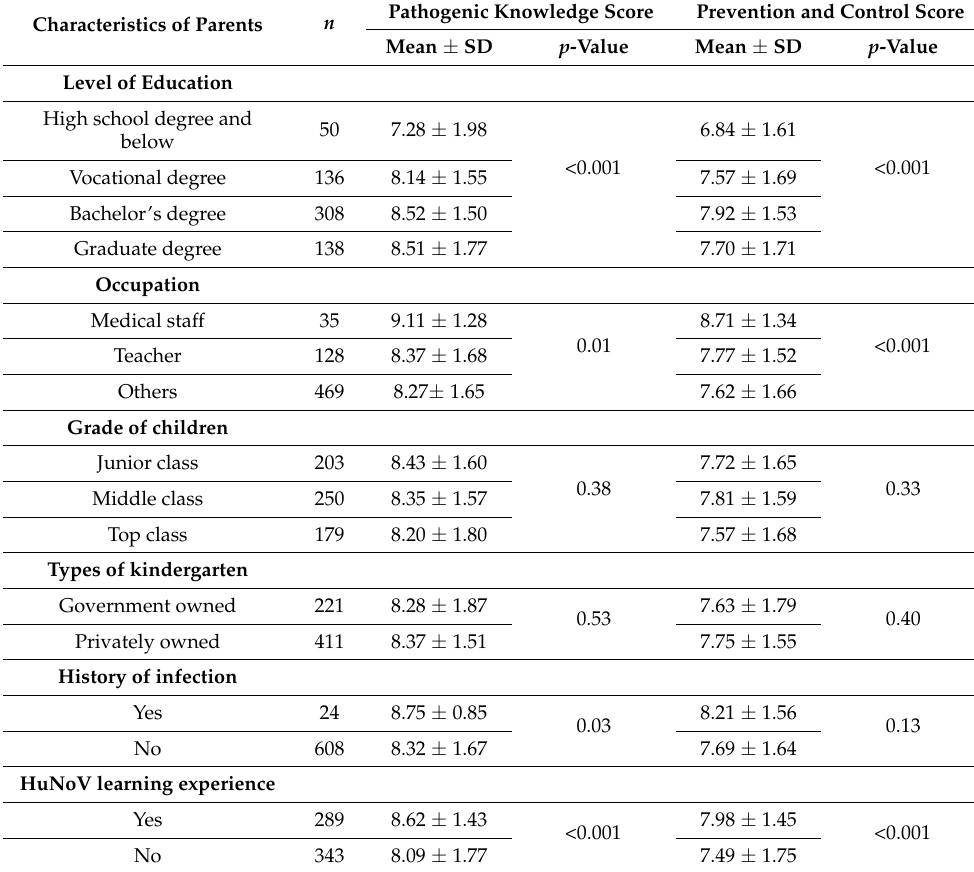
Table 1. Sociodemographic characteristics of parents ( n = 632) and their association with knowledge score. Pathogenic Knowledge Score Prevention and Control Score Characteristics of Parents n Mean ± SD p -Value Mean ± SD p -Value Level of